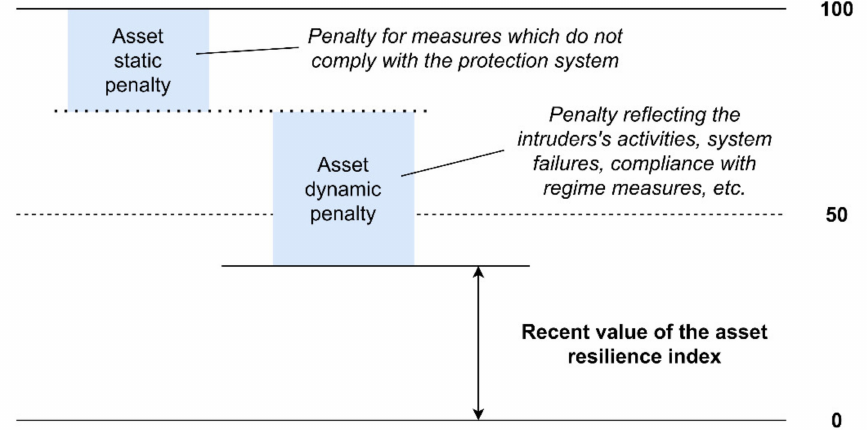
Figure 3. The essence of the calculation of the asset resilience index for individual security